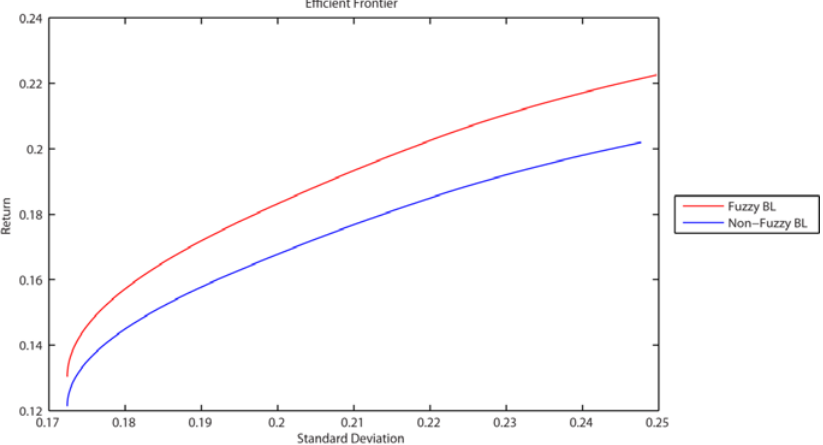
Fig. 2. Efficient frontier considering fuzzy and non-fuzzy BL model